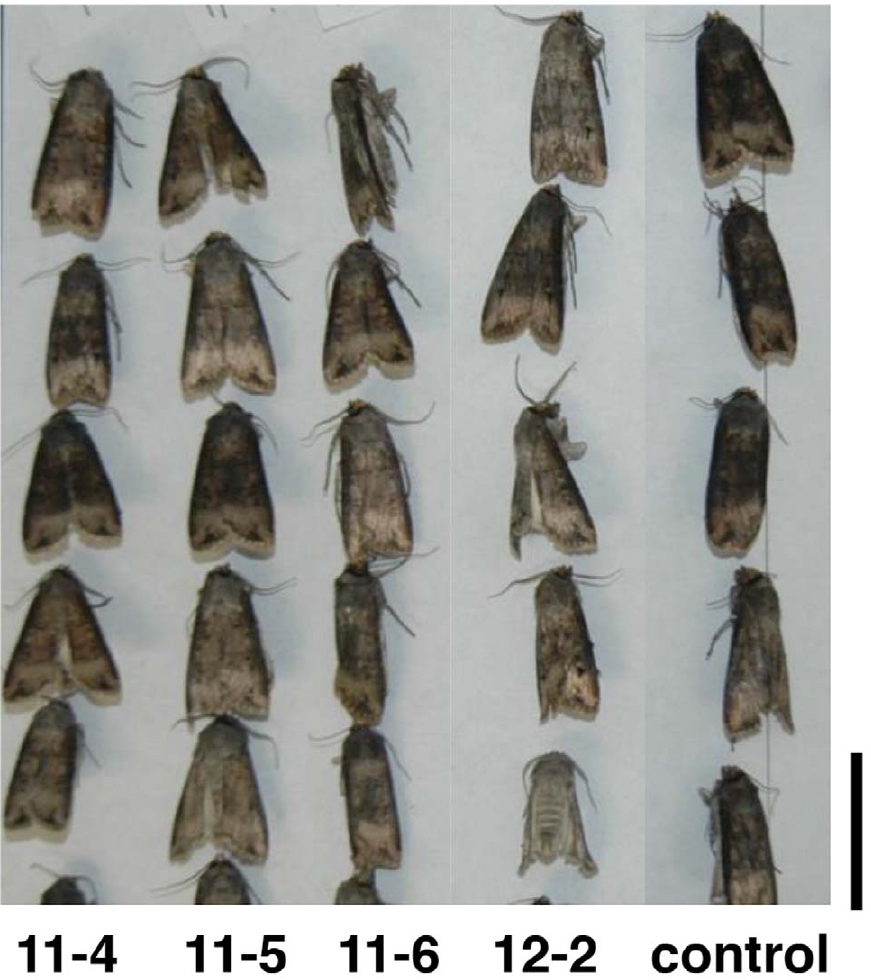
Figure 7. Black cutworm moths after feeding on N.benthamiana plants transformed with the BvSTI gene. Transformant 11-4, 11-5, 11-6 and 12-2 and untransformed normal control plant. Bar corresponds to 2 cm.